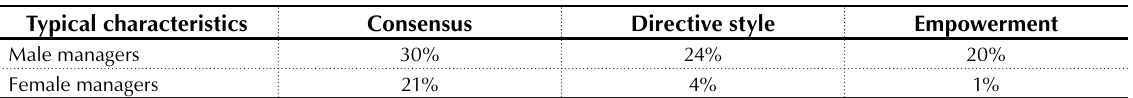
Source: elaborated by authors based on research